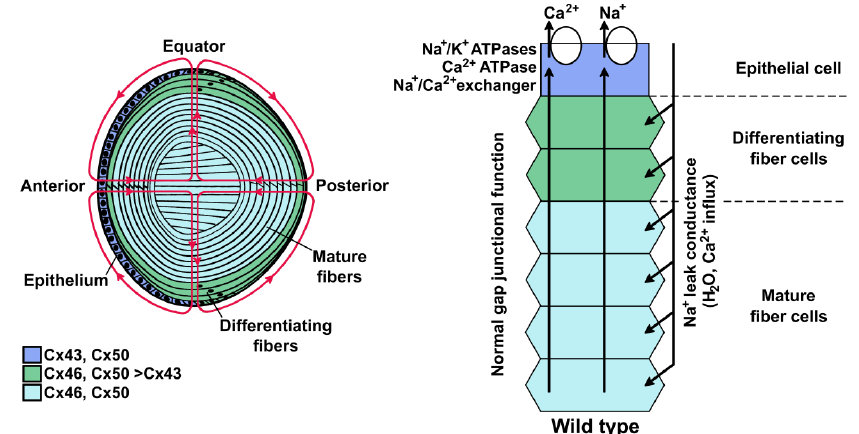
Figure 1. The lens and its internal circulation. Left, the diagram illustrates the distribution of connexins in the di ff erent regions of the lens and the circulation of ions and fluid (magenta lines with arrowheads to indicate direction of flow). Cells from the anterior epithelium express connexin43 (Cx43) and connexin50 (Cx50). Di ff erentiating fiber cells express Cx43, connexin46 (Cx46), and Cx50, but the expression of Cx43 is downregulated as di ff erentiation proceeds. Mature fiber cells express Cx46 and Cx50. In the lens circulation, ions and fluid enter into the extracellular spaces at the anterior and posterior poles and they exit across epithelial cell membranes at the equator. Right, the diagram depicts the ion circulation and some of the components that support it in a cellular column encompassing the lens surface to its center. Ions enter di ff erentiating fiber and mature fiber cells through the plasma membrane driven by their electrochemical gradient, and they move back to the surface from cell-to-cell through gap junction-mediated electro-di ff usion and advection. Once they reach the cells in the epithelium, the ions are transported out of the lens by pumps and transporters. Modified from Gao et al. (left panel, Figure 1; right panel, Figure 8A)